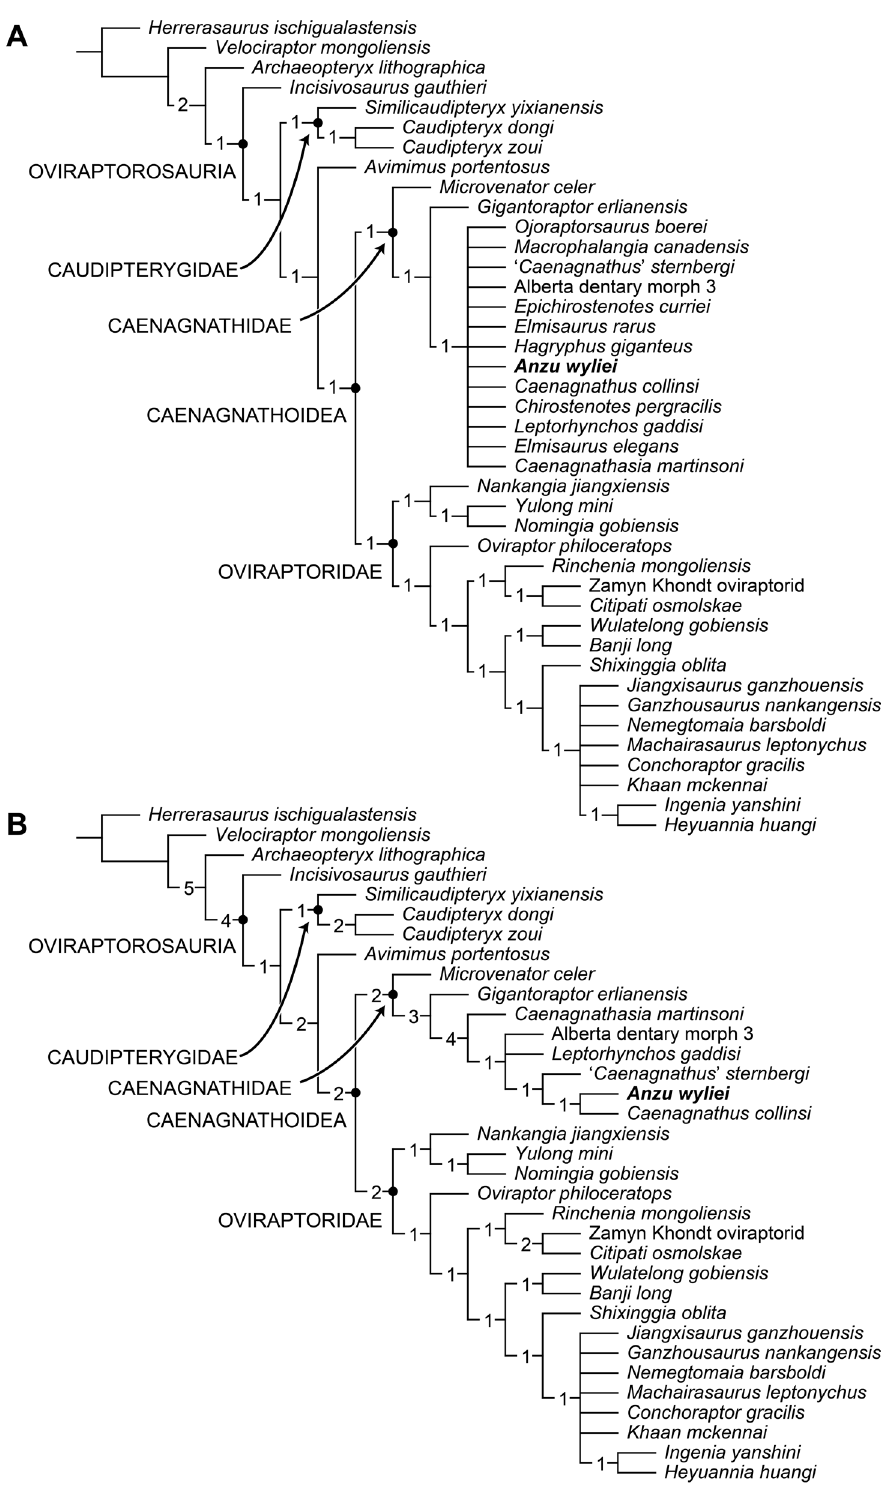
Figure 6. Strict consensus trees resulting from successive trials of phylogenetic analysis. Numbers adjacent to each node are Bremer support values; named nodes are indicated with black dots. ( A ) Strict consensus of 2,610 most parsimonious trees of 509 steps recovered by initial analysis of all 41 taxa (38 oviraptorosaurs) included in the matrix. ( B ) Strict consensus of seven most parsimonious trees of 498 steps resulting from an analysis of 34 taxa (31 oviraptorosaurs), excluding all members of Caenagnathidae (as recovered by the initial trial) for which definitive mandibular material has not yet been discovered.